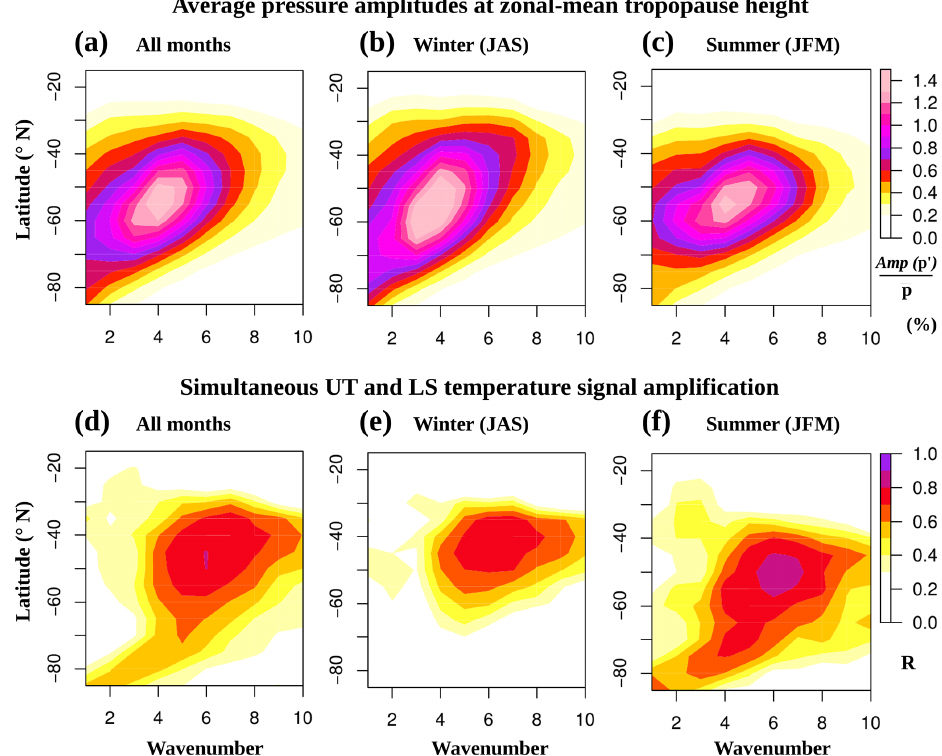
Figure 4. Same as Fig. 3 but for the Southern